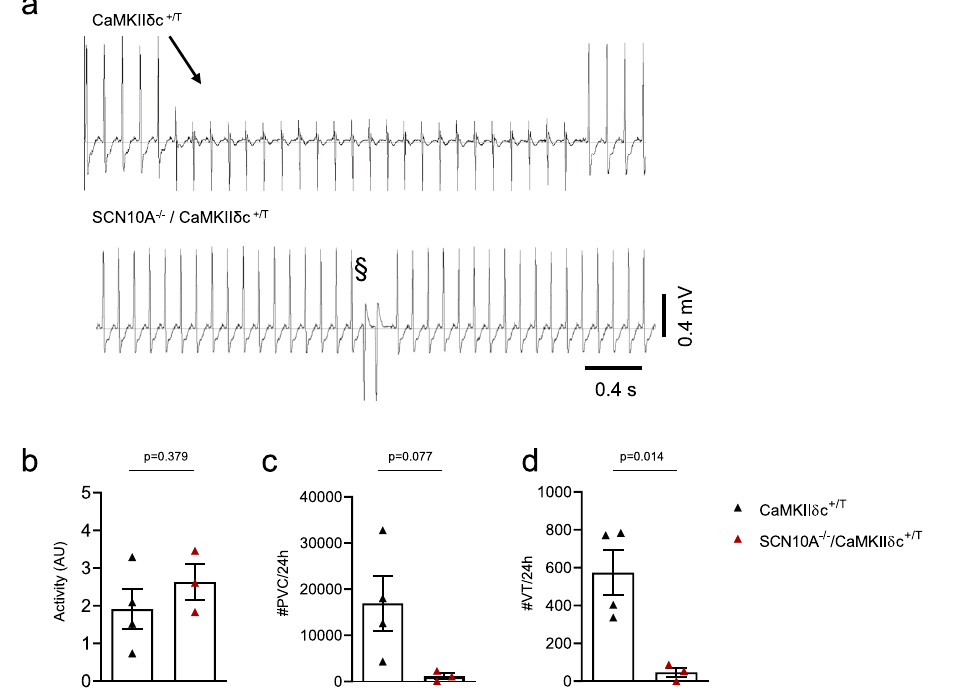
Fig. 6 SCN10A − / − /CaMKII δ c + /T exhibit less in vivo arrhythmias compared to CaMKII δ c + /T mice. a Original ECG traces from telemetry recordings of 10- week-old CaMKII δ c + /T and SCN10A − / − /CaMKII δ c + /T mice showing ventricular arrhythmias. b Unchanged activity levels in SCN10A − / − /CaMKII δ c + /T compared to CaMKII δ c + /T (CaMKII δ c + /T (four mice); SCN10A − / − /CaMKII δ c + /T (three mice), four individual recordings each). Data were presented as mean values±SEM, analyzed by unpaired two-tailed Student ’ s t -test. c Mean values of premature ventricular contractions (PVCs) in SCN10A − / − /CaMKII δ c + /T ( p = 0.08, Unpaired two-tailed Student ’ s t -test), CaMKII δ c + /T (four mice); SCN10A − / − /CaMKII δ c + /T (three mice), four individual recordings each. Data were presented as mean values±SEM. d Reduction of ventricular tachycardia (VT) incidence in SCN10A − / − /CaMKII δ c + /T ( p <0.05, Unpaired two-tailed Student ’ s t -test), CaMKII δ c + /T (four mice); SCN10A − / − /CaMKII δ c + /T (three mice), four individual recordings each. Data were presented as mean